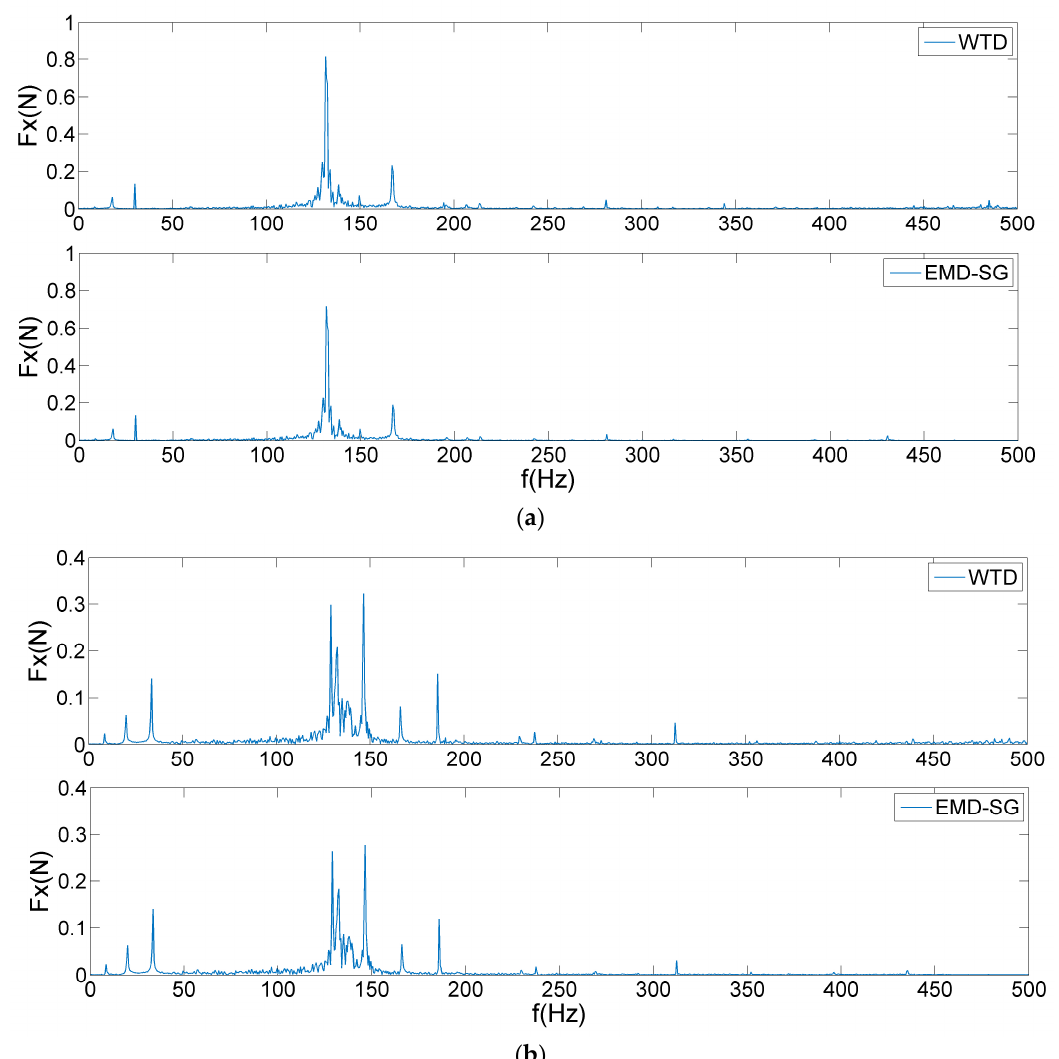
Figure 13. Spectra of micro-vibration signals by WTD and EMD–SG: ( a ) 1800 rpm; ( b ) 2000 rpm.